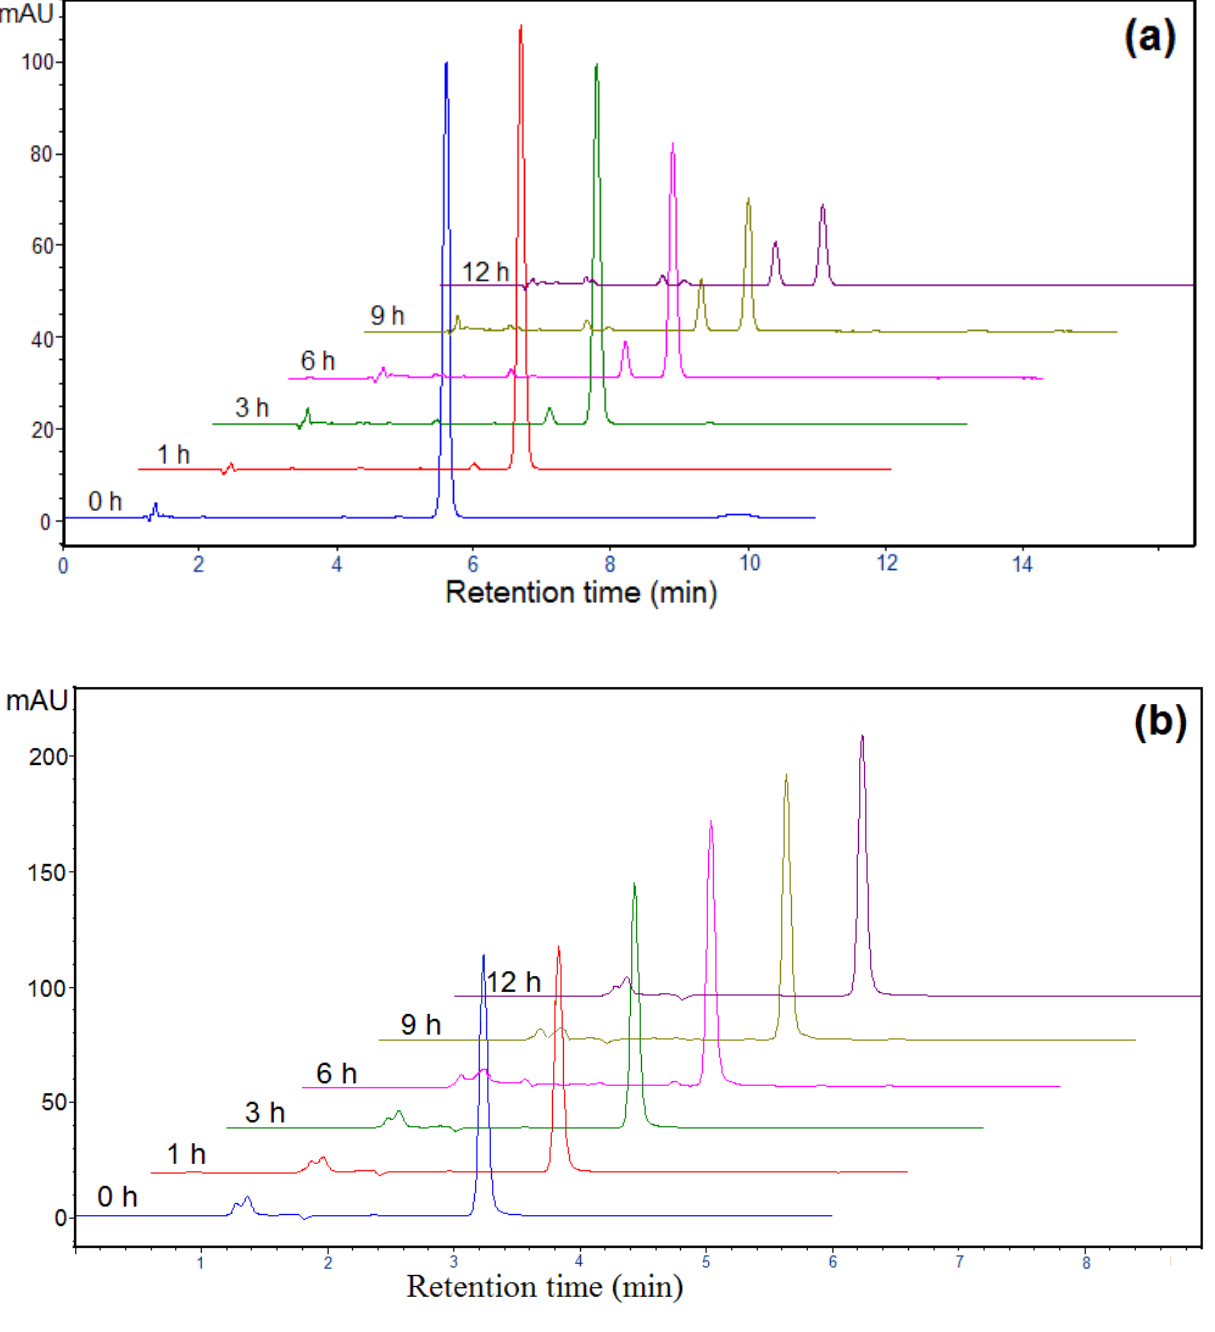
Figure 7. HPLC profiles during the mecoprop (2.7 mmol/dm 3 ), λ = 228 nm (a) and clopyralid (1.0 mmol/dm 3 ), λ = 225 nm (b) photocatalytic degradation in the presence of N-doped TiO (1.0 mg/cm 3 ) using visible 2